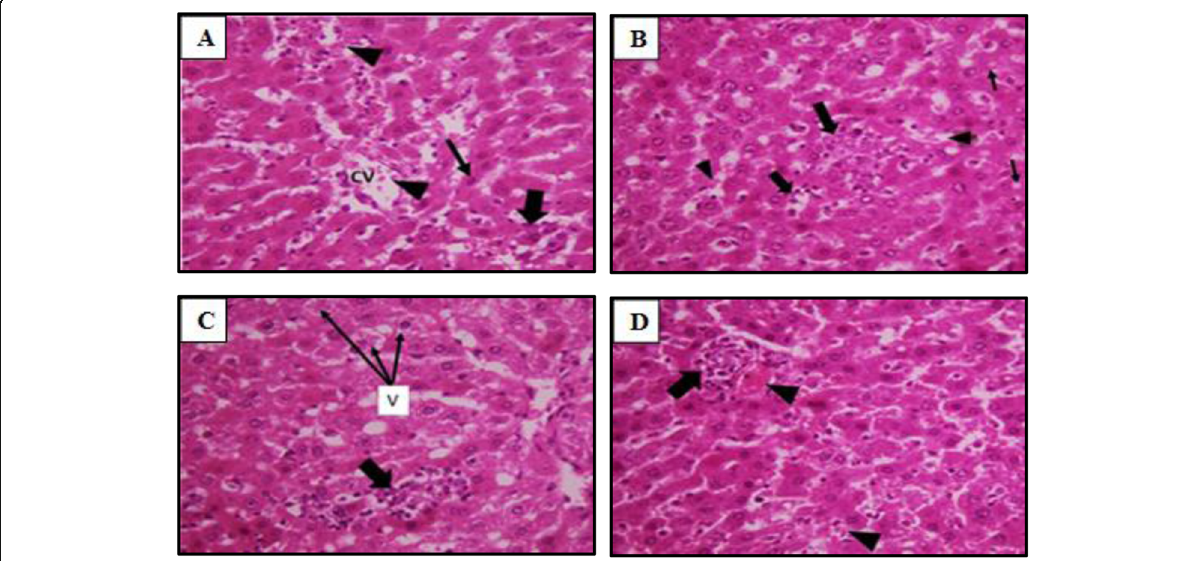
Fig. 5 Photomicrograph of liver tissue sections of a L -arginine-treated hepatic ischemia-reperfusion group, b exercise-trained hepatic ischemia- reperfusion group, c oxytocin-treated hepatic ischemia-reperfusion group, and d exercise-trained and oxytocin-treated hepatic ischemia- reperfusion group. (H&E